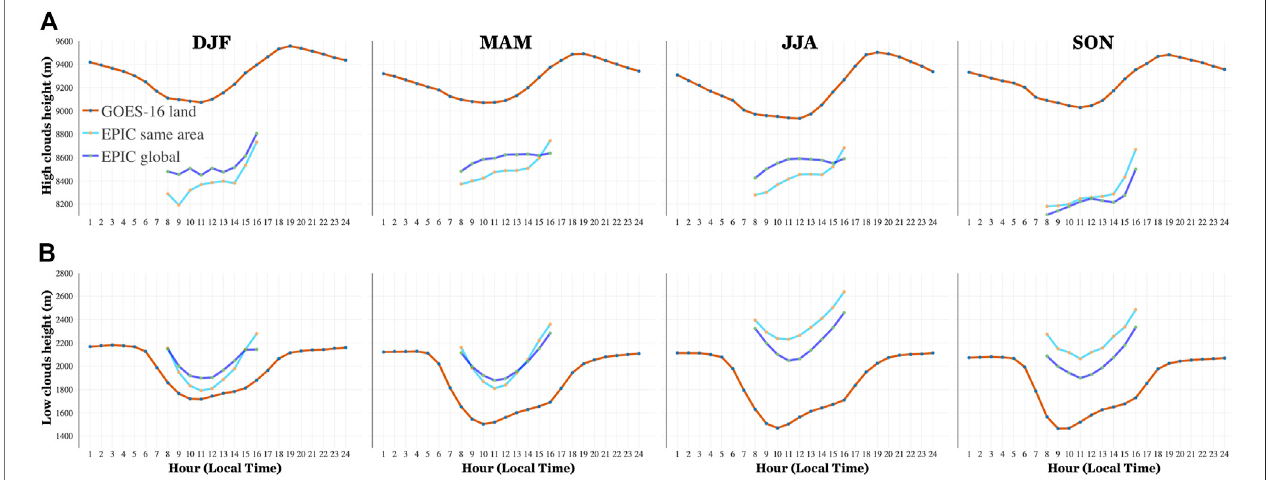
FIGURE2| DiurnalcyclesofcloudheightforGOES-16(redline)andEPICoverland.EPICresultsareshownforthewholeglobe(darkblue)andforthesameareas as GOES-16 (light blue). Each column is a different season for high (A) and low (B) clouds.